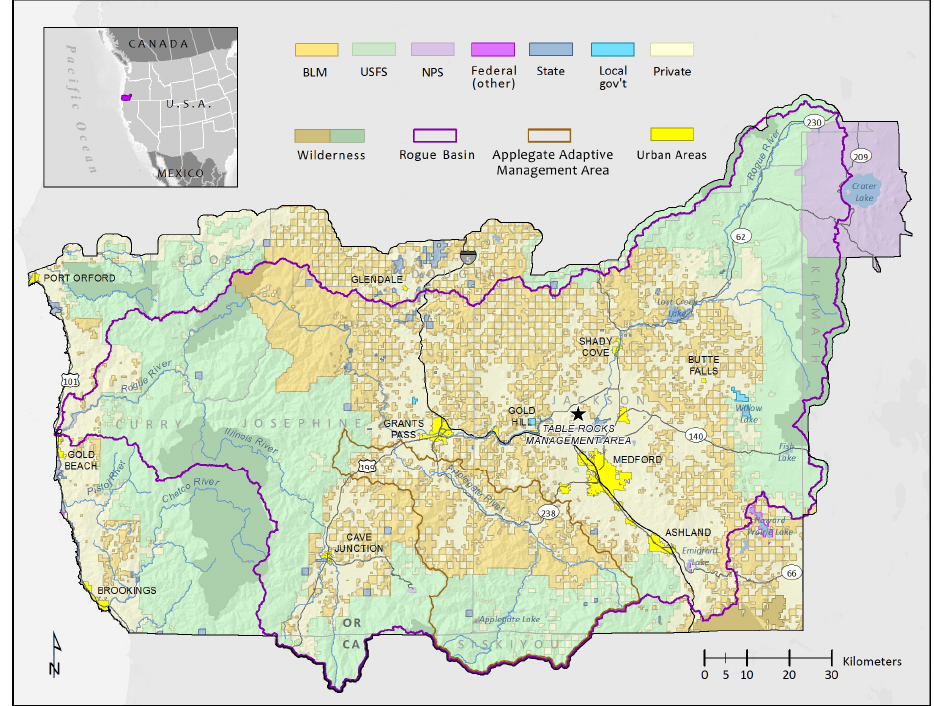
Figure 1. Study area location and land management/ownership in southwestern Oregon, USA. 117 Federal land management agencies include the Bureau of Land Management (BLM), the U.S. Forest 118 Service (USFS), and the National Park Service (NPS). The Applegate Adaptive Management Area and 119